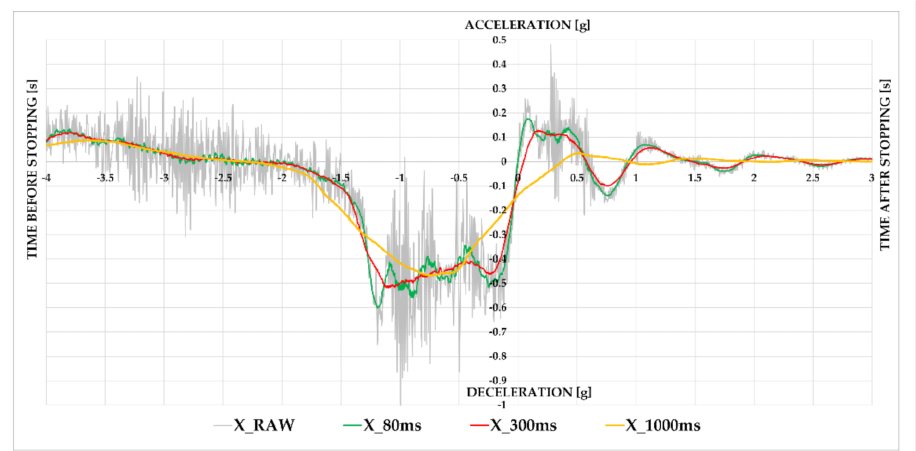
Figure 3. Effect of evaluation time on the course of braking obtained from sensor B during a semi- trailer’s